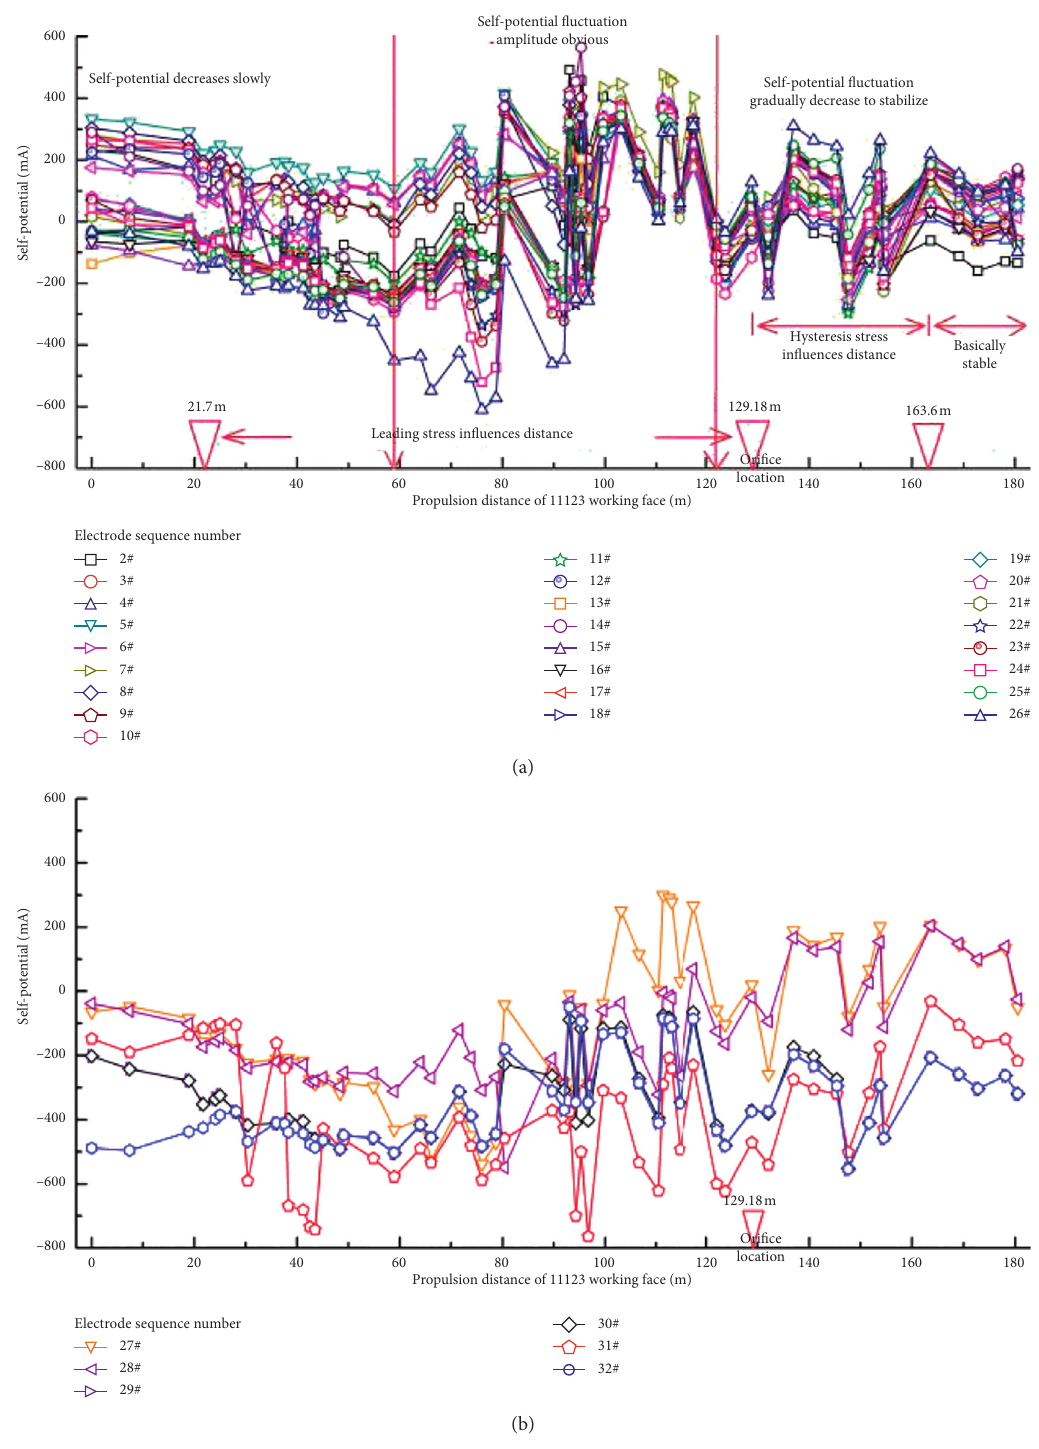
Figure 8: Self-potential curves at different